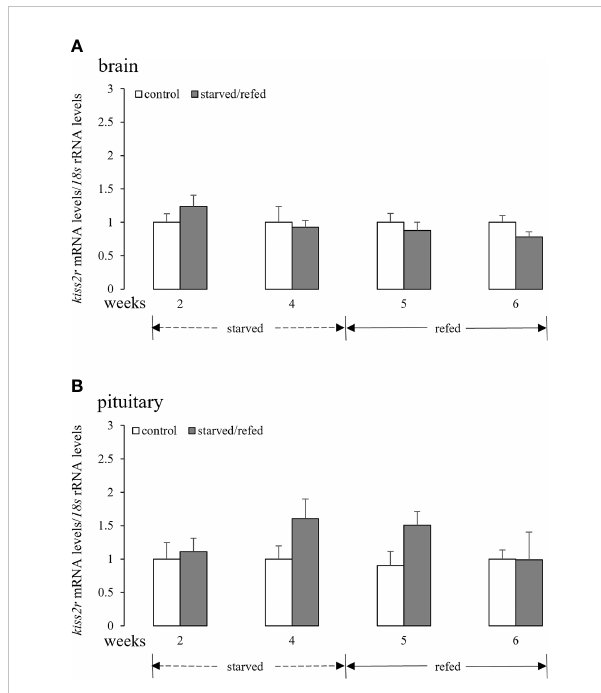
FIGURE 4 Effects of nutritional status on the brain (A) and pituitary (B) kiss2r mRNA levels in half-smooth tongue sole. Data were normalized against 18s transcripts and are presented as mean ± SEM (n = 4). A star indicates signi fi cant difference between fed and starved/refed groups ( p <